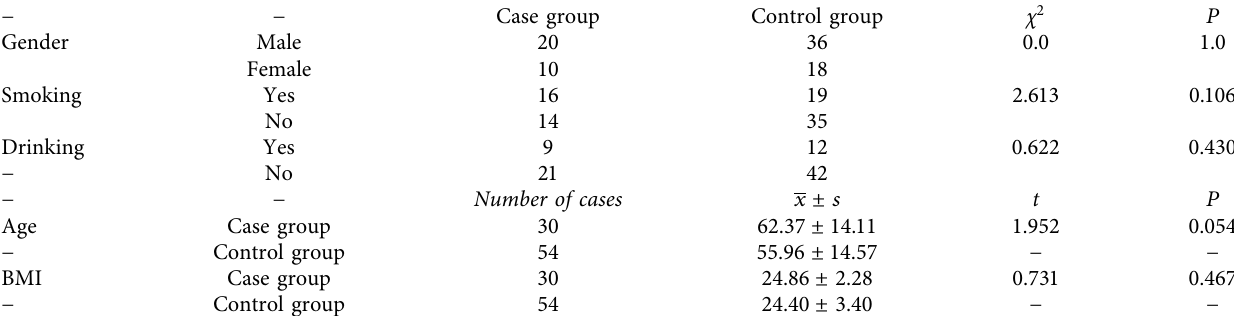
Table 1: Comparison of general clinical information between the case and control groups.